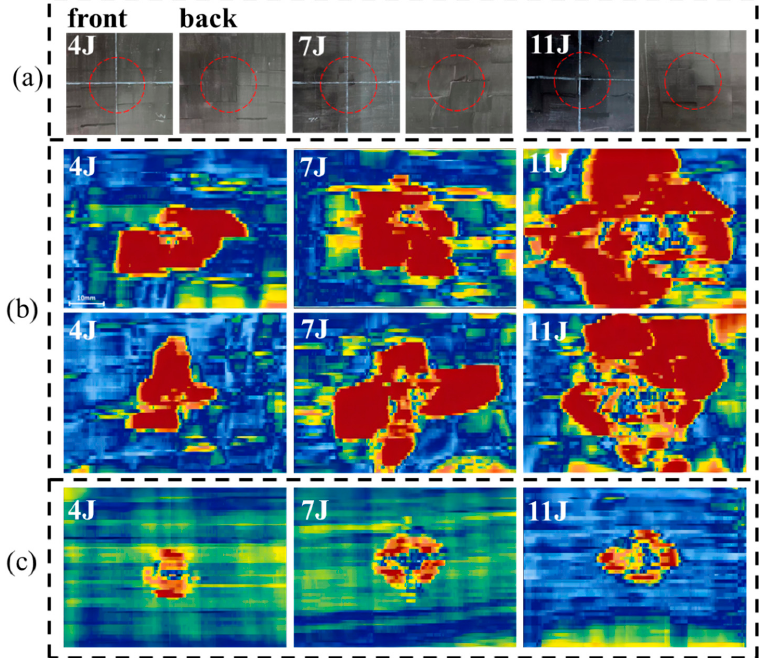
Figure 9. Comparison of C-scan maps and damaged specimens impacted at 4 J, 7 J and 11 J. ( a ) Damaged UACS laminates, ( b ) C-scan maps of UACS laminates and ( c ) C-scan maps of continuous CFRP